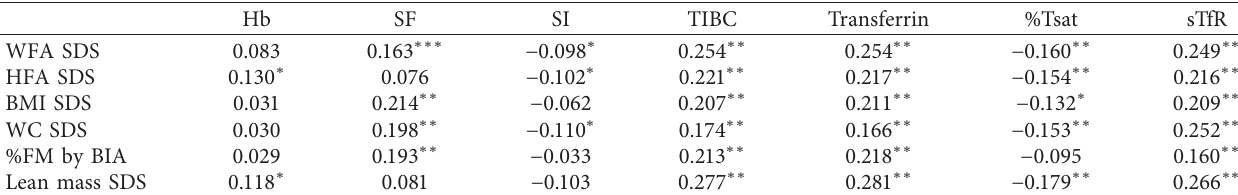
Table 3: Correlation coefficients between each iron index and anthropometry.